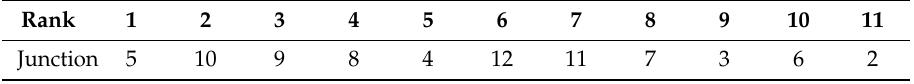
Table 3. Results of sensitivity analysis according to the change in the Hazen–Williams